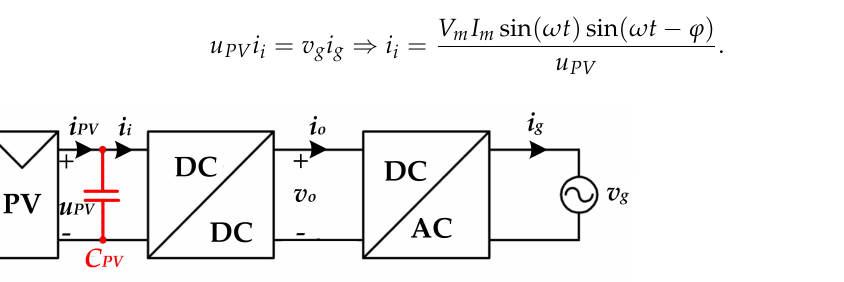
Figure 1. Power decoupling capacitor in parallel with the PV array and DC–DC boost